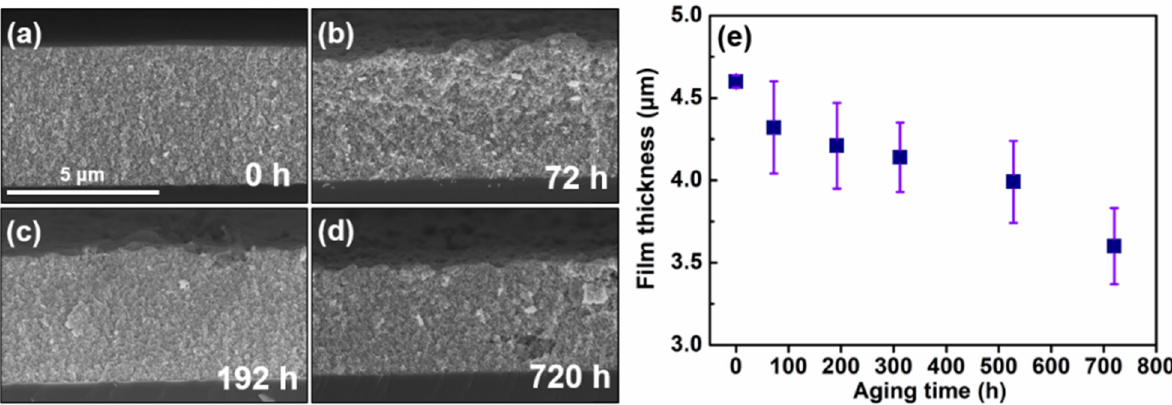
Figure 2. SEM images ( a – d ) of the films fabricated from Cu 2-x S NPs after various aging times (top panel: positive electrode; bottom panel: negative electrode). For the negative electrode, a plot of NP surface coverage against aging time is presented in ( e ).